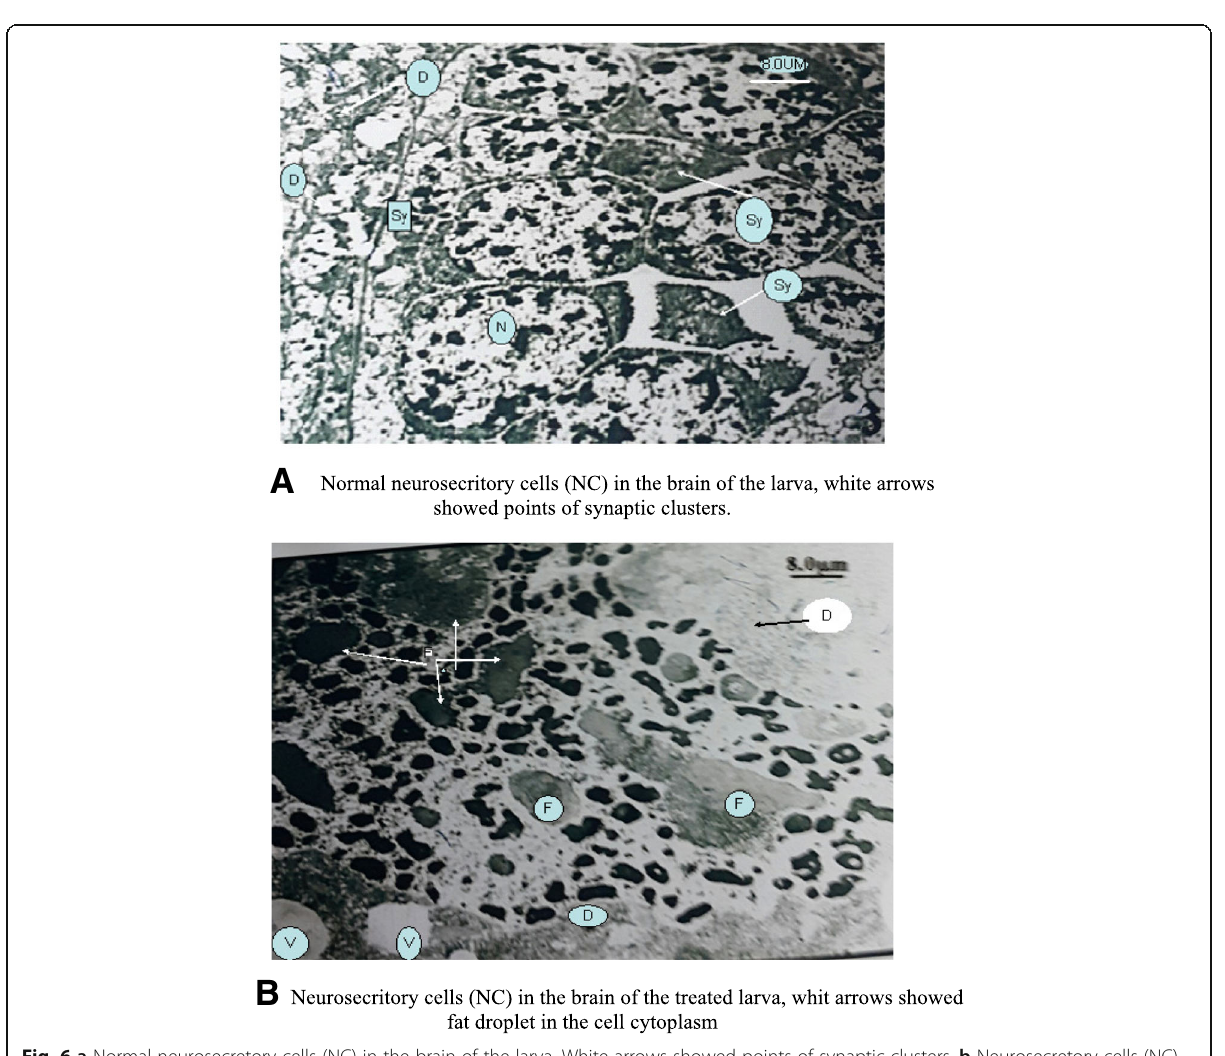
Fig. 6 a Normal neurosecretory cells (NC) in the brain of the larva. White arrows showed points of synaptic clusters. b Neurosecretory cells (NC) in the brain of the treated larva. White arrows showed fat droplet in the cell cytoplasm. Sections in different tissues of the endocrine system of the potato tuber moth Phthorimaea operculalla larva detected under electron microscope observation . a The normal untreated tissues. b Treated tissues of larva reared on potato tubers covered with talcum powder containing 0.5% each of basil extract + B.t + GV and 25 g/1 kg